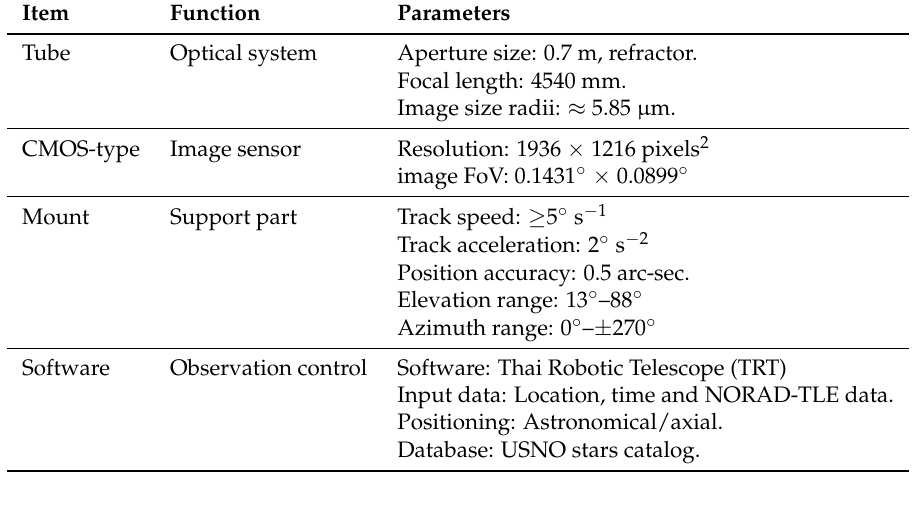
Table 1. Specifications of TNSO telescope .